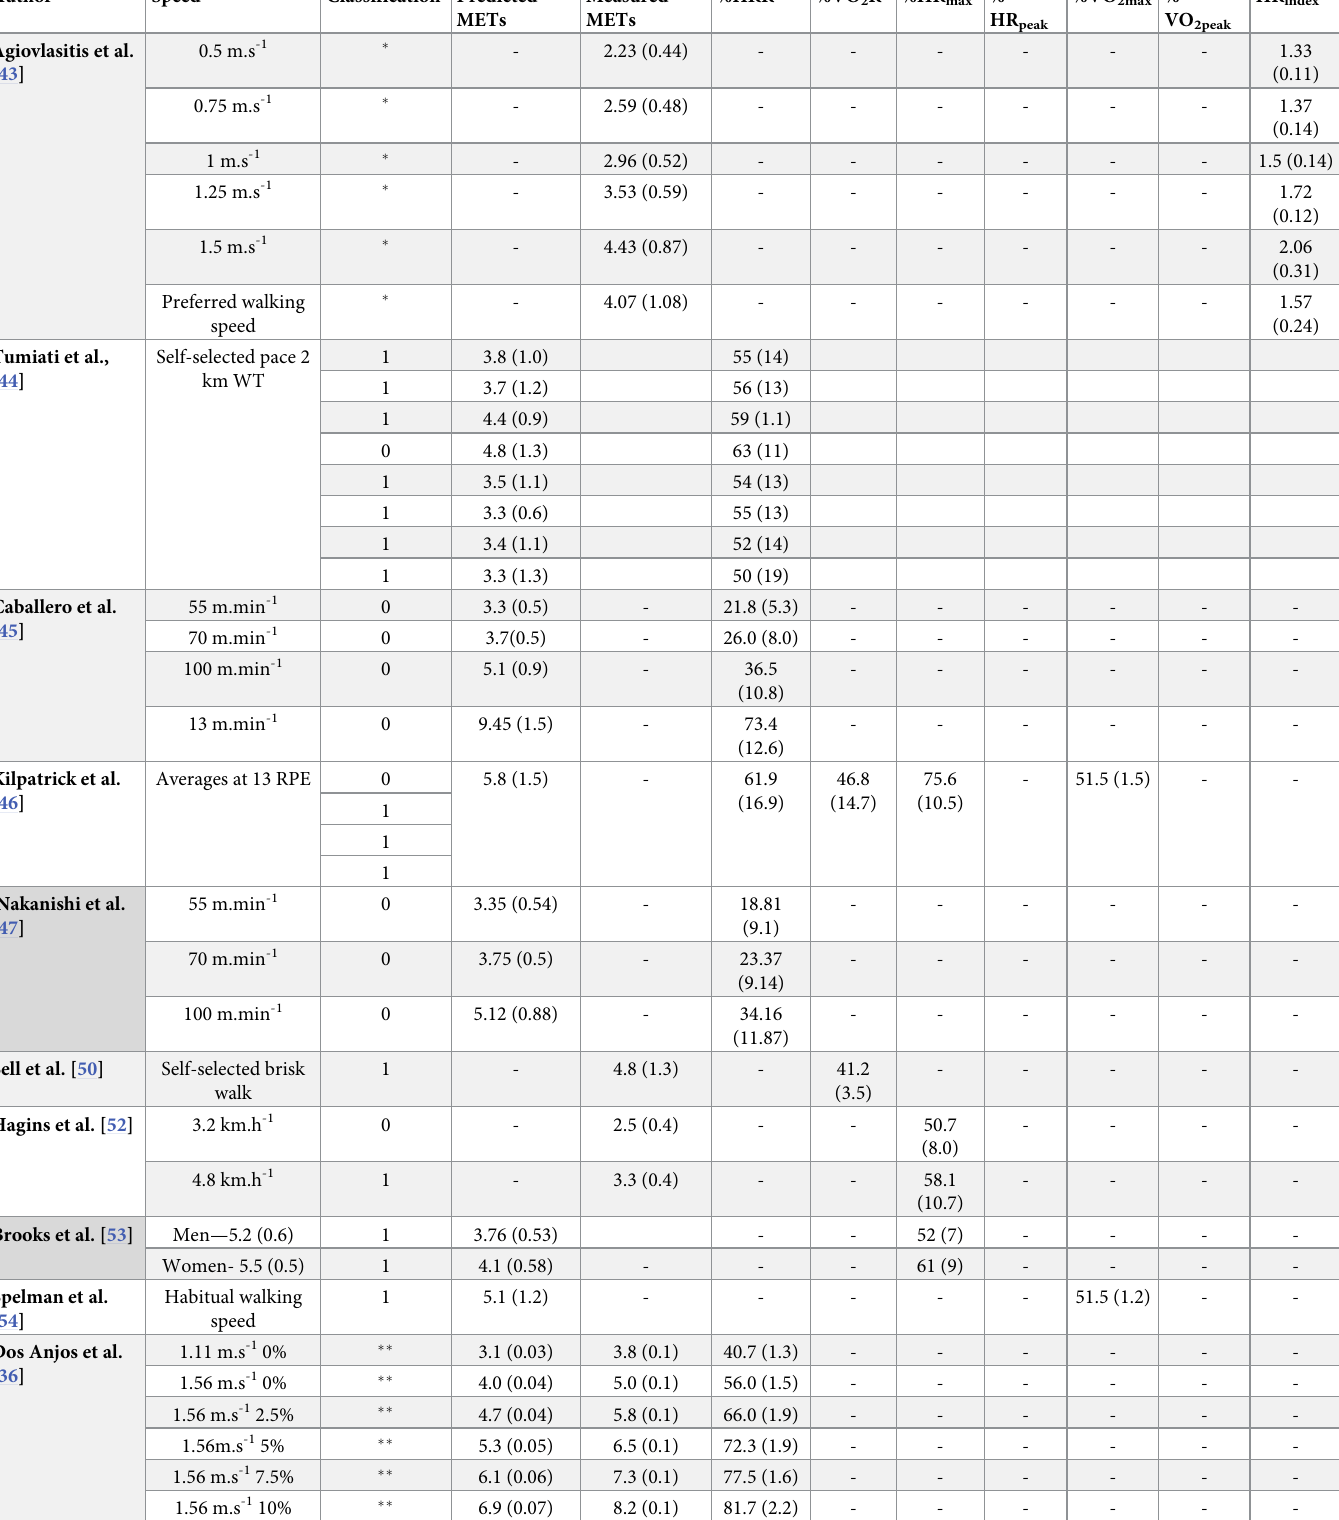
Table 2. Mean (SD) for measures of relative and absolute exercise intensity from each study included in the systematic review and meta-regression.